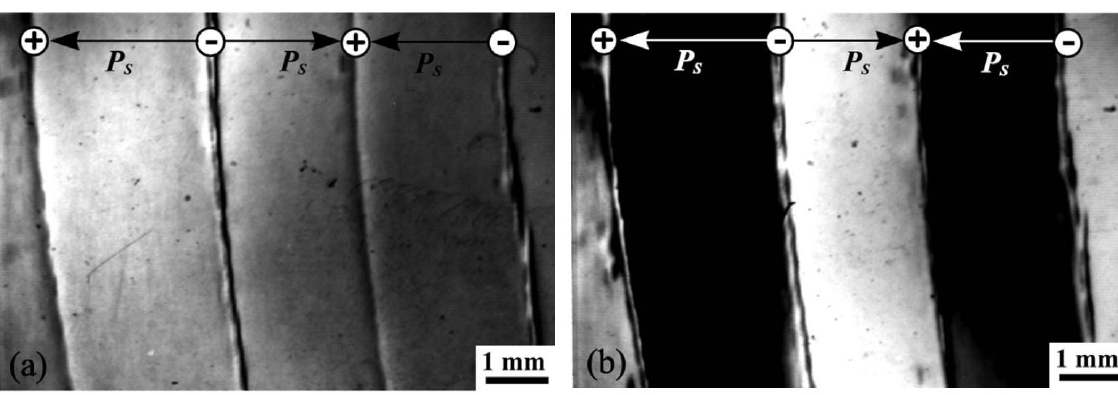
Figure 10. Contrast intensification in the [030] reflection of a lithium niobate crystal